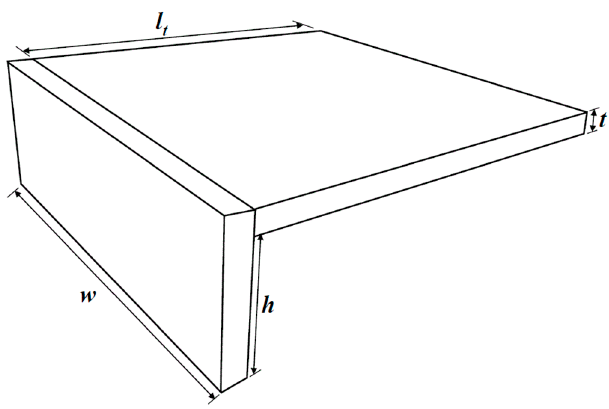
Figure 3. Schematic diagram of the mobility system for heavy-weight tracked vehicles.